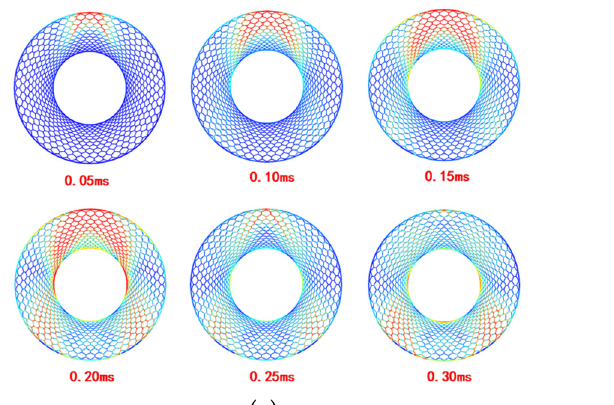
Figure 7. Strain time-history curves of the pentamode lattice-ring structure and the solid ring with equal mass.